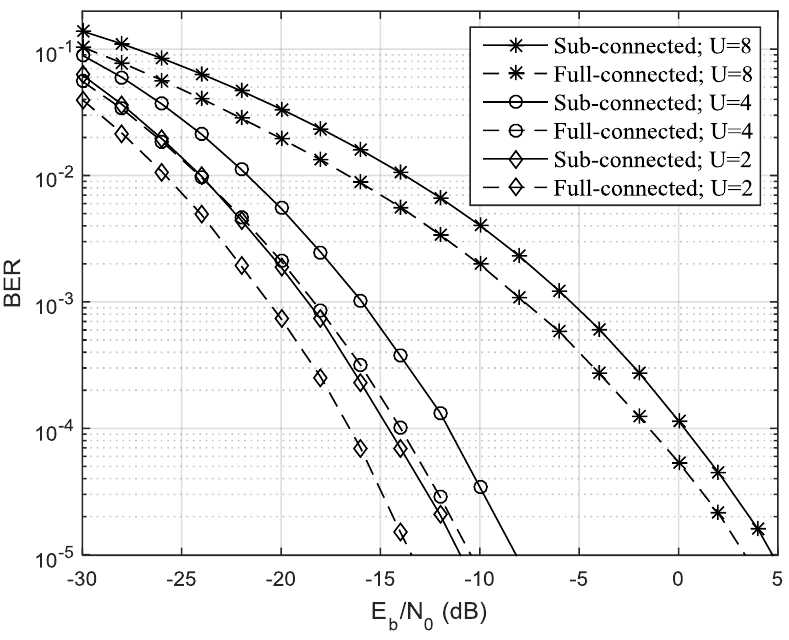
Figure 3. Performance of the proposed hybrid sub-connected scheme for U ∈ { 2,4,8 } . BER is bit-error-rate.